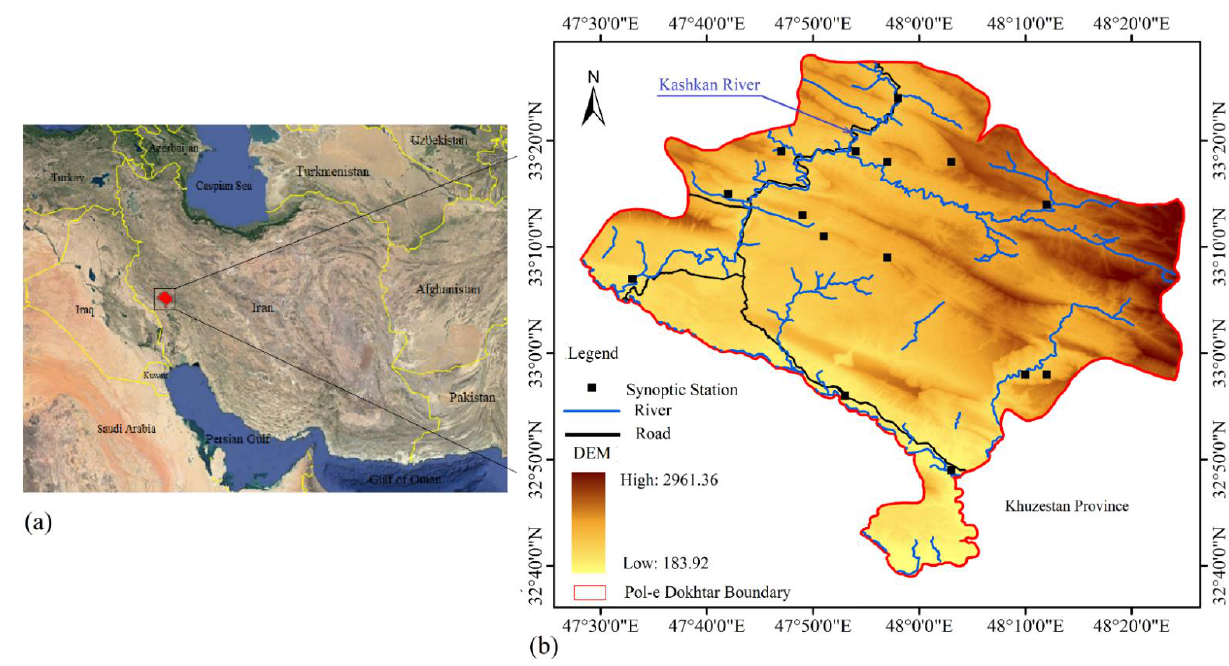
Figure 1. ( a ) Iran, ( b ) study area (Pol-e Dokhtar watershed).